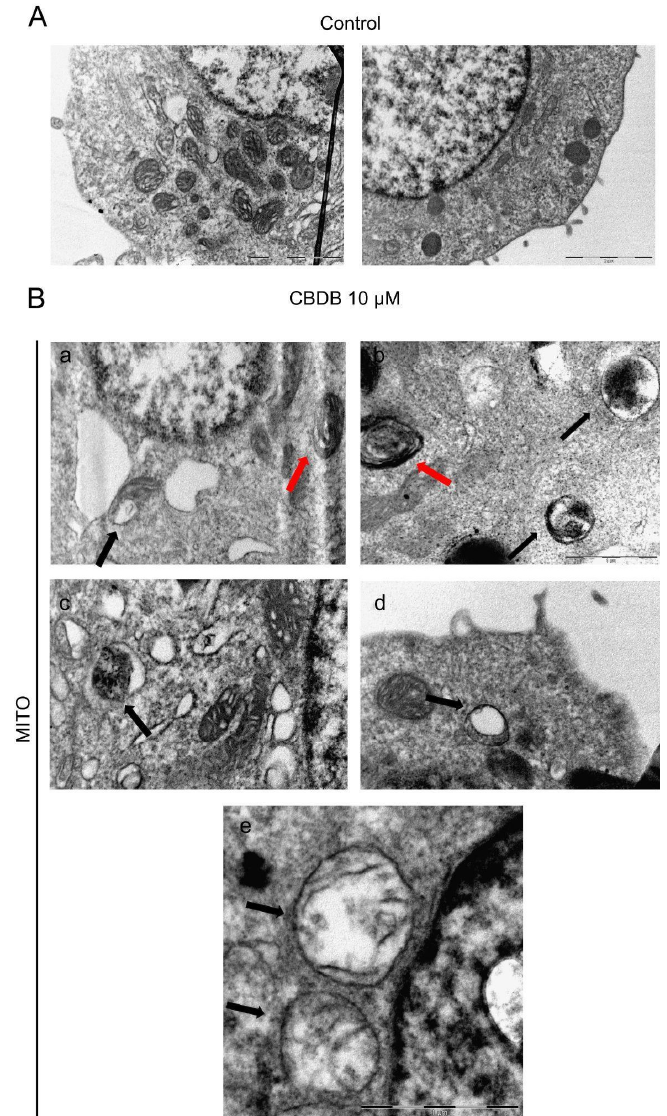
Figure 5. Representative TEM images of cell morphology. ( A ) MCF-7 control cells (treated with DMSO as a vehicle). Scale bar 2 µm. ( B ) MCF-7 cells exposed to CBDB or CBDP (10 µM) for 24 h. Mitochondria with dilated cristae( panel a , b , red arrows); swollen mitochondria with crests in the process of breaking (panel a – e ; black arrows). Scale bar 1 µm.